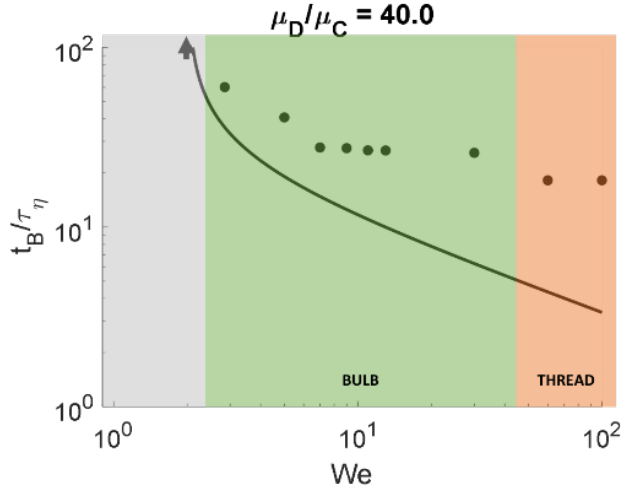
Figure 9. Time of initial breakup, t B , as a function of Weber number, We, for a high viscosity drop ( μ D /μ C = 40). Solid line displays average breakup time as suggested by Rivière et al. [24]. Arrows indicate cases with t B > 90 τ η . Colored fields show breakup morphology; see Figure 8.